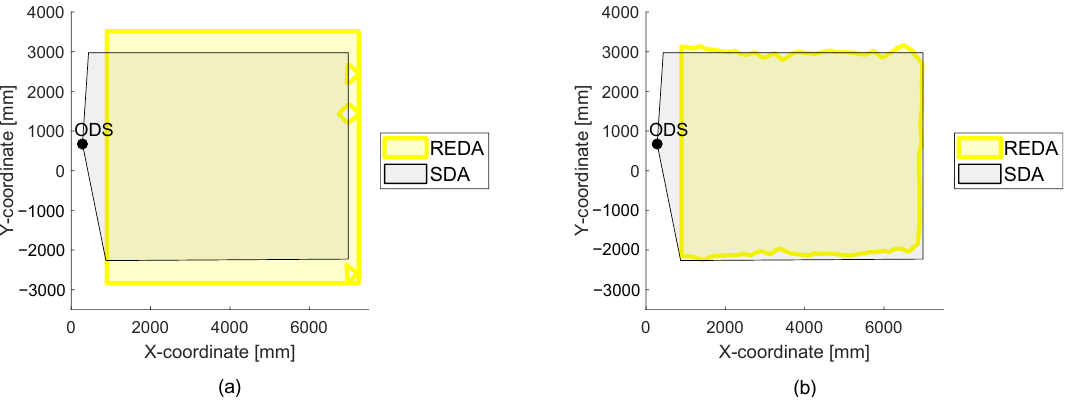
Figure 9. The figure presents two measurements from the 2D LiDAR sensor example of this article. In part ( a ), a REDA is shown with a visibility under 200 m due to fog. In part ( b ), a REDA is shown with no restriction of visibility due to fog. Both measurements have the same parameters and test